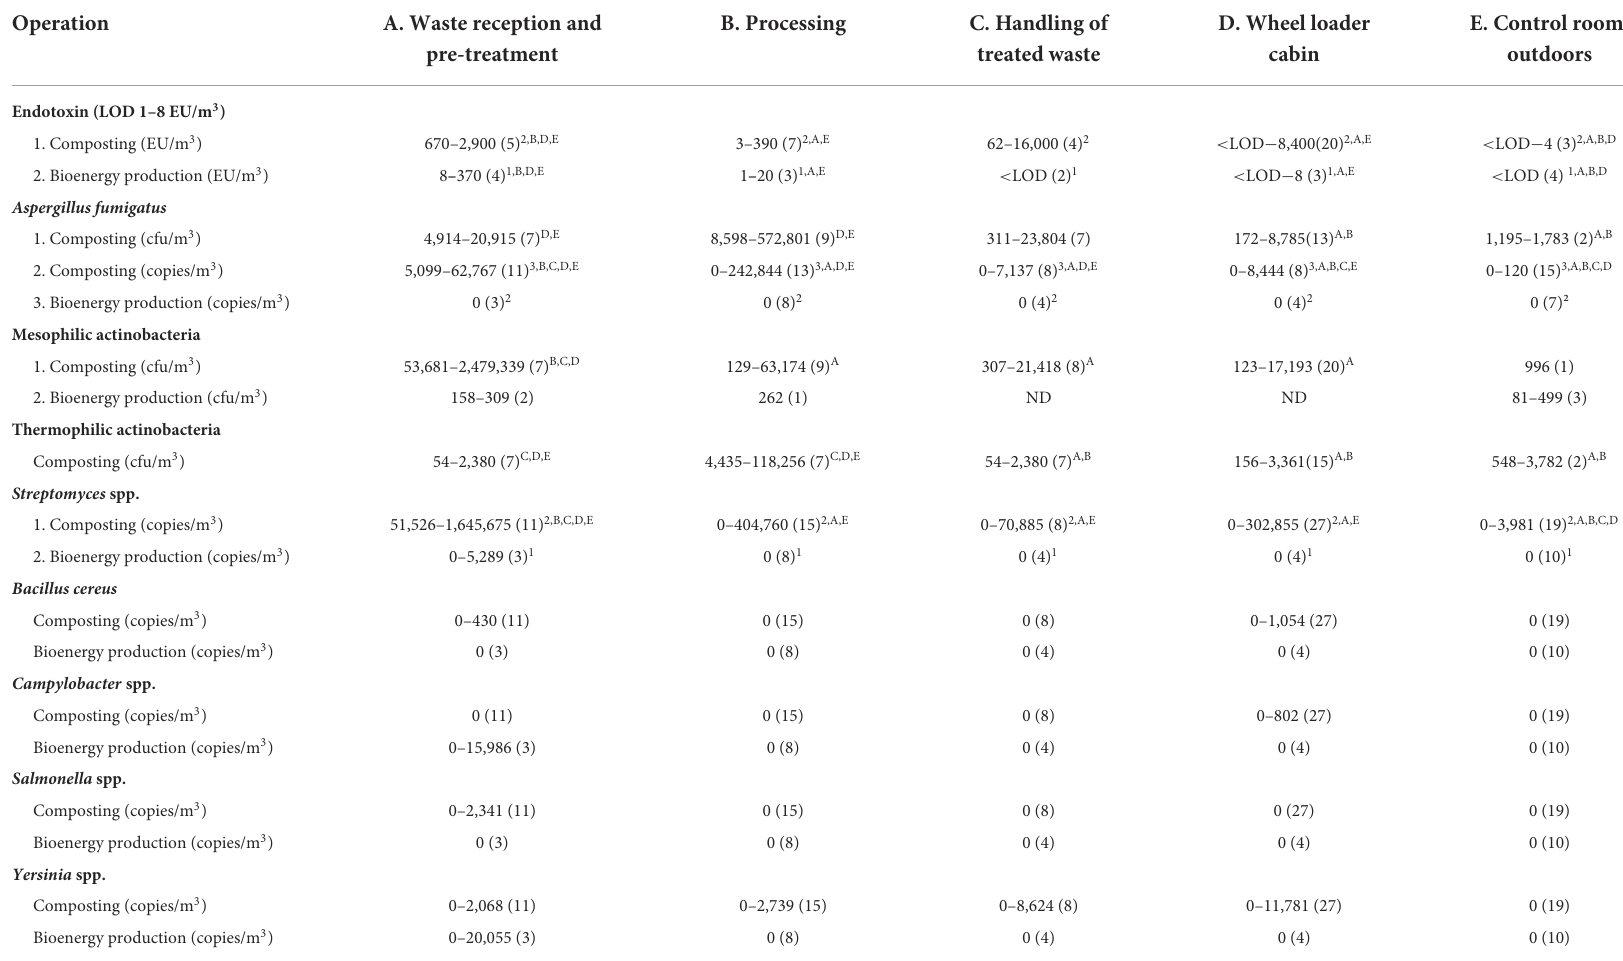
TABLE 1 Ranges of variation for endotoxins; for plate counts of A. fumigatus , and mesophilic and thermophilic actinobacteria; and for copy numbers of A. fumigatus , Streptomyces spp., B. cereus group, Campylobacter spp., Salmonella spp., and Yersinia spp. DNA in composting and bioenergy production facilities.